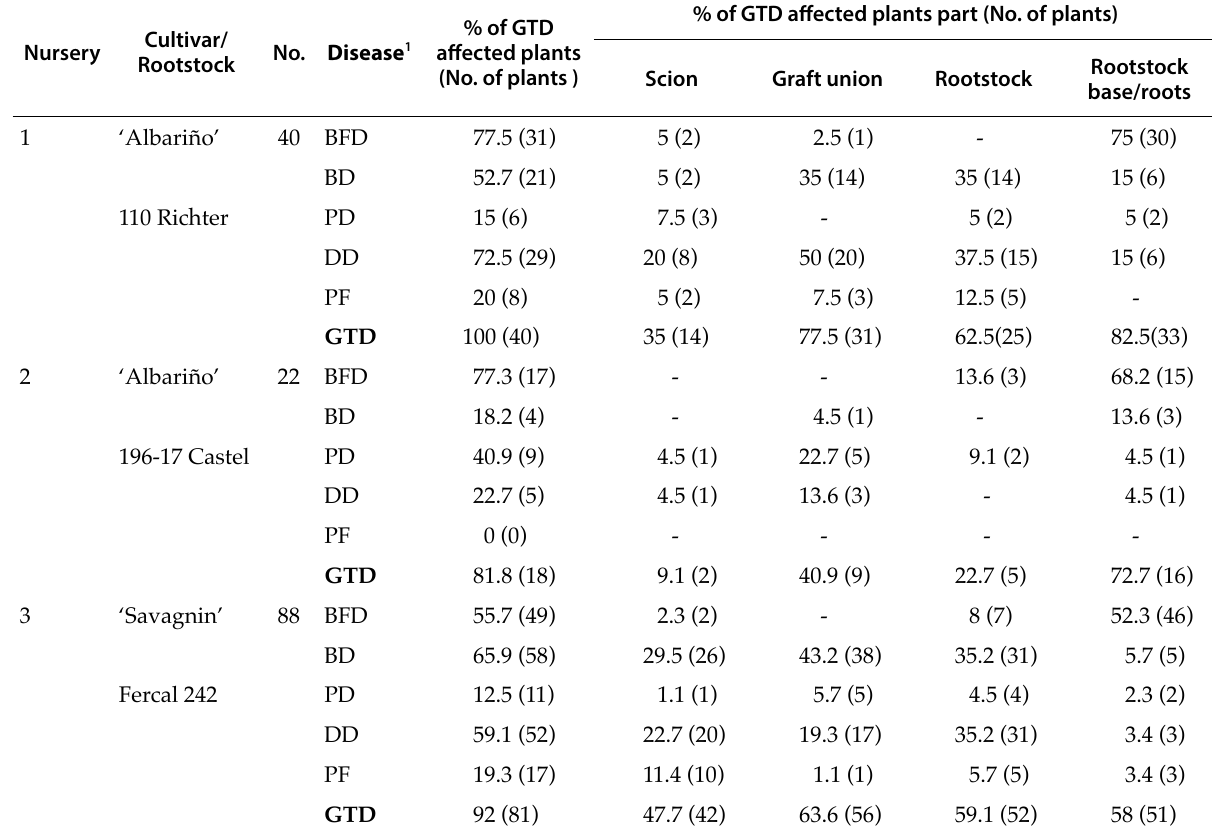
Table 3. Incidence of grapevine trunk diseases (%) in plants of ‘Albariño’ and ‘Savagnin’ grapevine varieties from three nurseries, grafted onto 110R, 196-17 or Fercal 242 rootstocks, expressed by, plant parts and nursery.